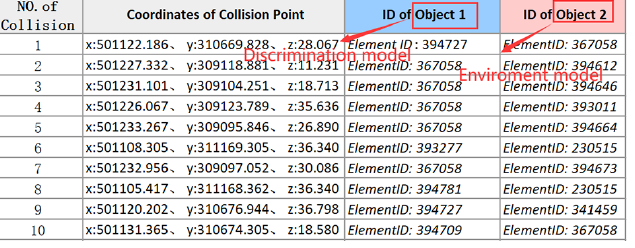
Figure 14. Part of the generated collision report Figure 15. Environmental model integrated into BIM